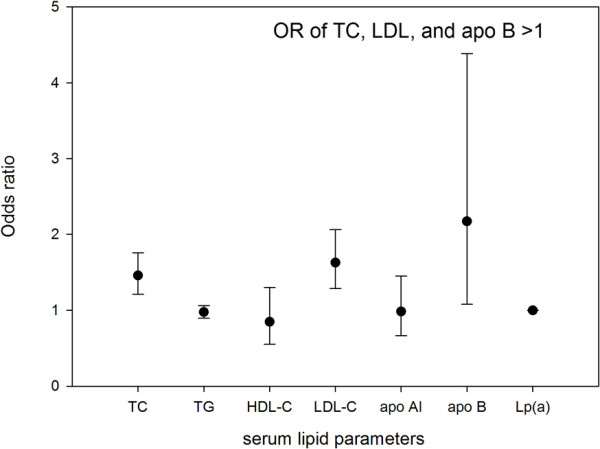
Odds ratio and confidence interval of lipid parameters (TC- total cholesterol; TG- triglycerides; HDL-C- high density lipoprotein cholesterol; LDL-C- low density lipoprotein cholesterol; Apo A1- apolipoprotein A1; Apo B- apolipoprotein B; Lp(a)- lipoprotein A).